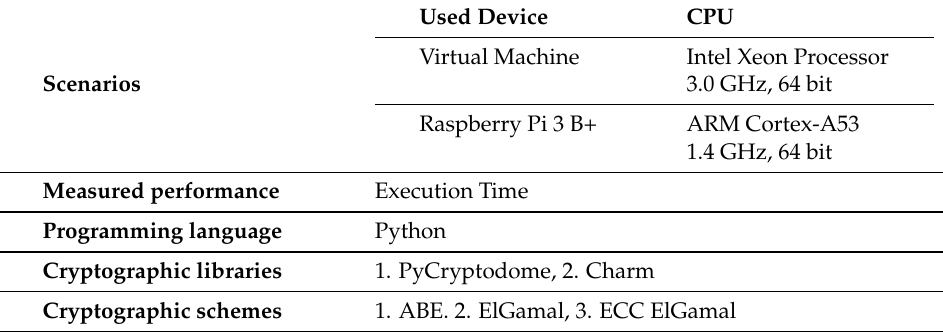
Table 2. Performance evaluation specifications.